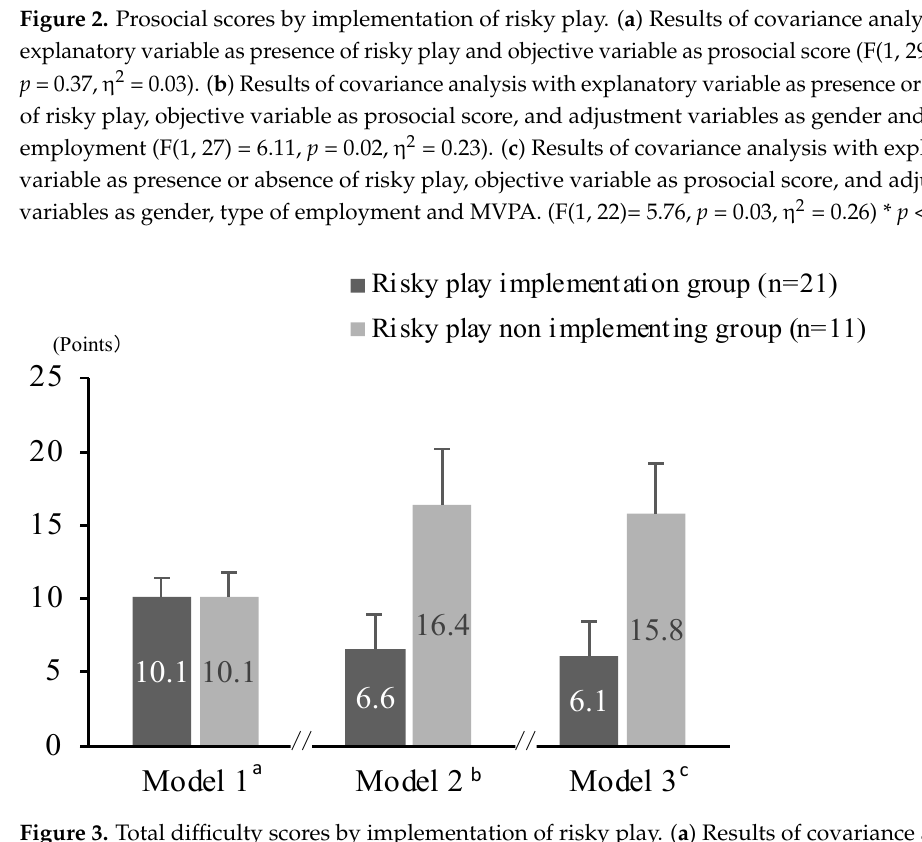
Figure 3. Total difficulty scores by implementation of risky play. ( a ) Results of covariance analysis with explanatory variable as presence of risky play and objective variable as total difficulty score